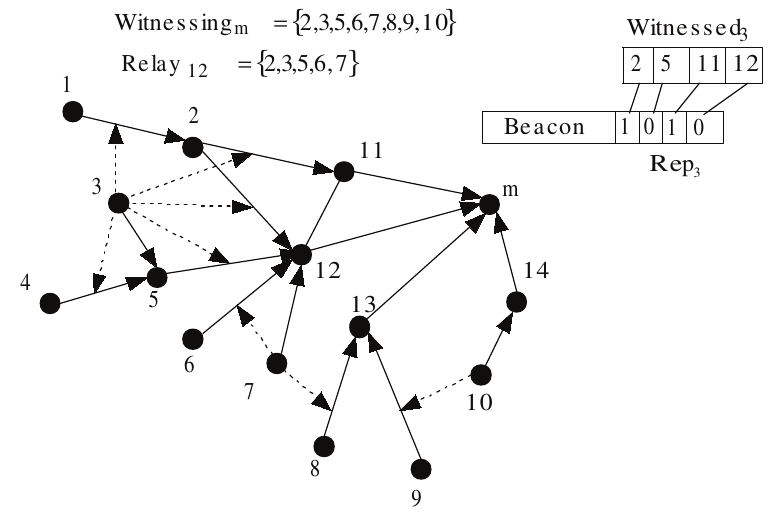
Figure 4. Initialization and rating